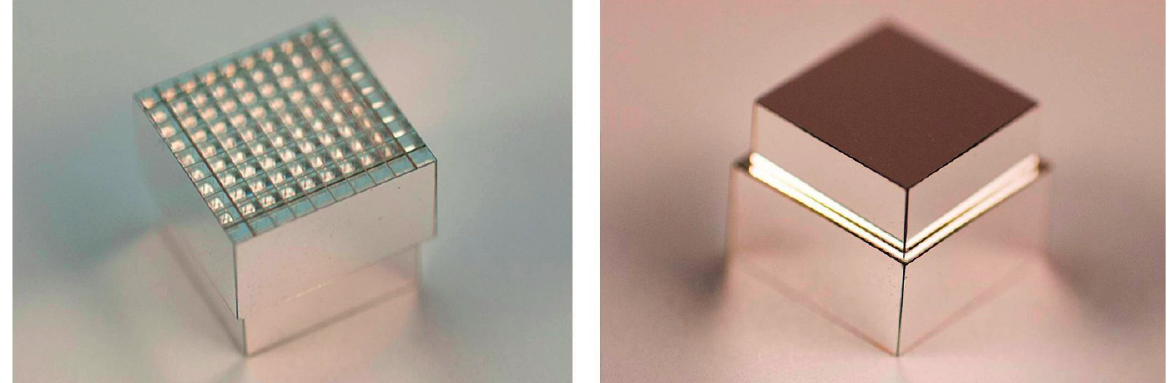
Figure 5. Two views of block of LYSO crystals used in the study. There are 10 × 10 1.2 mm crystals in the lower layer (shown exposed here) and 9 × 9 1.2 mm crystals in the upper layer. The layers are offset by ½ of the crystal